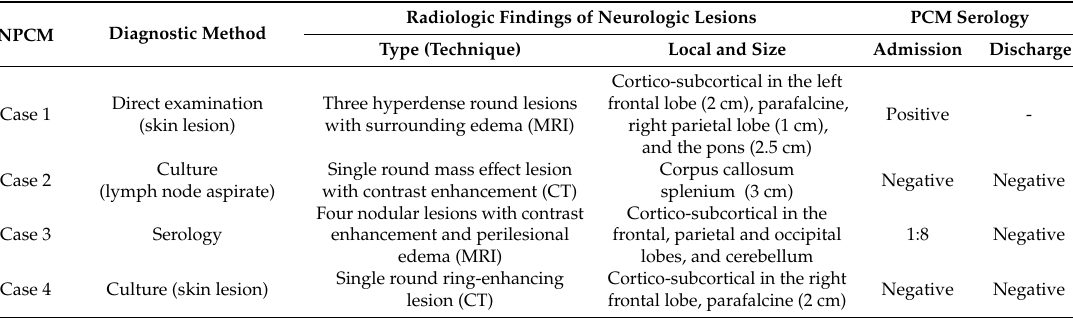
Table 2. Laboratorial and radiological findings of the NPCM cases from this